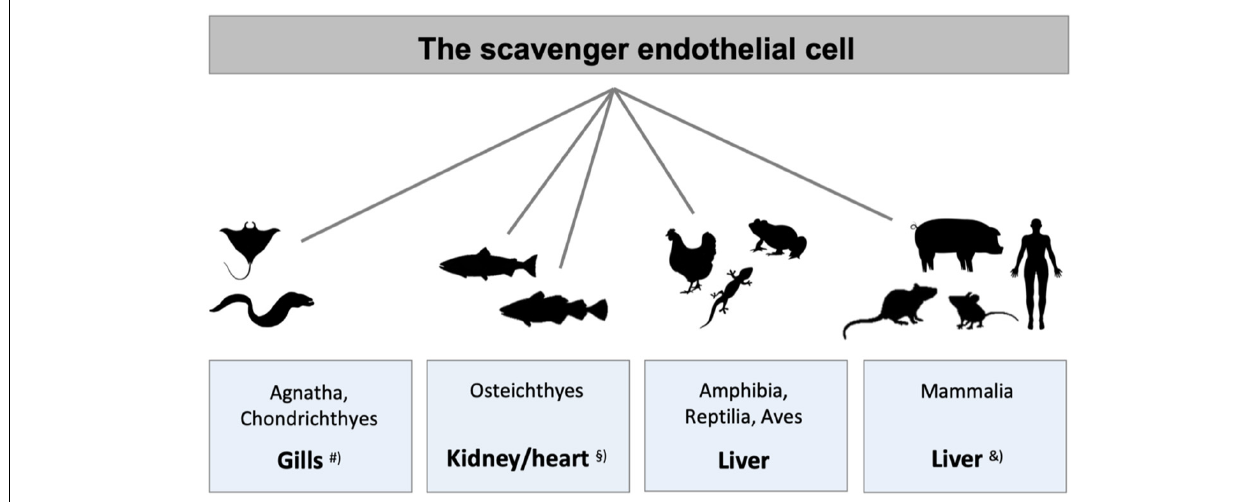
FIGURE 3 | Species differences in the localization of main populations of scavenger endothelial cells (SECs). The figure illustrates the organs that harbor the main populations of specialized SECs in different vertebrate classes. # SECs are localized in special gill arteries in hagfish, lamprey (both Agnatha), and ray (Chondrichthyes) (Seternes et al., 2002). § In adult bony fish (Osteichthyes) SECs constitute the endothelium of the venous sinusoids in the kidney hematopoietic tissue in crucian carp (Seternes et al., 2002) and salmonid fish (Dannevig et al., 1990, 1994; Smedsrød et al., 1993; Seternes et al., 2002), and the atrial and ventricular endocardium in Atlantic cod (Smedsrød et al., 1995; Sørensen et al., 1997, 1998, 2001; Seternes et al., 2001a, 2002). In all higher vertebrate classes LSECs represent the major SEC population, studied in frog (Seternes et al., 2002), lizard (Seternes et al., 2002), chicken (Seternes et al., 2002), rodents (Smedsrød et al., 1990b; Seternes et al., 2002; Sørensen et al., 2015), and pig (Nedredal et al., 2003; Elvevold et al., 2004). & In addition to the central scavenger function of LSECs in mammals, studies in rabbit and rodents also show scavenging function of the sinusoidal endothelium in spleen, bone marrow, and lymph nodes (Fraser et al., 1983; Qian et